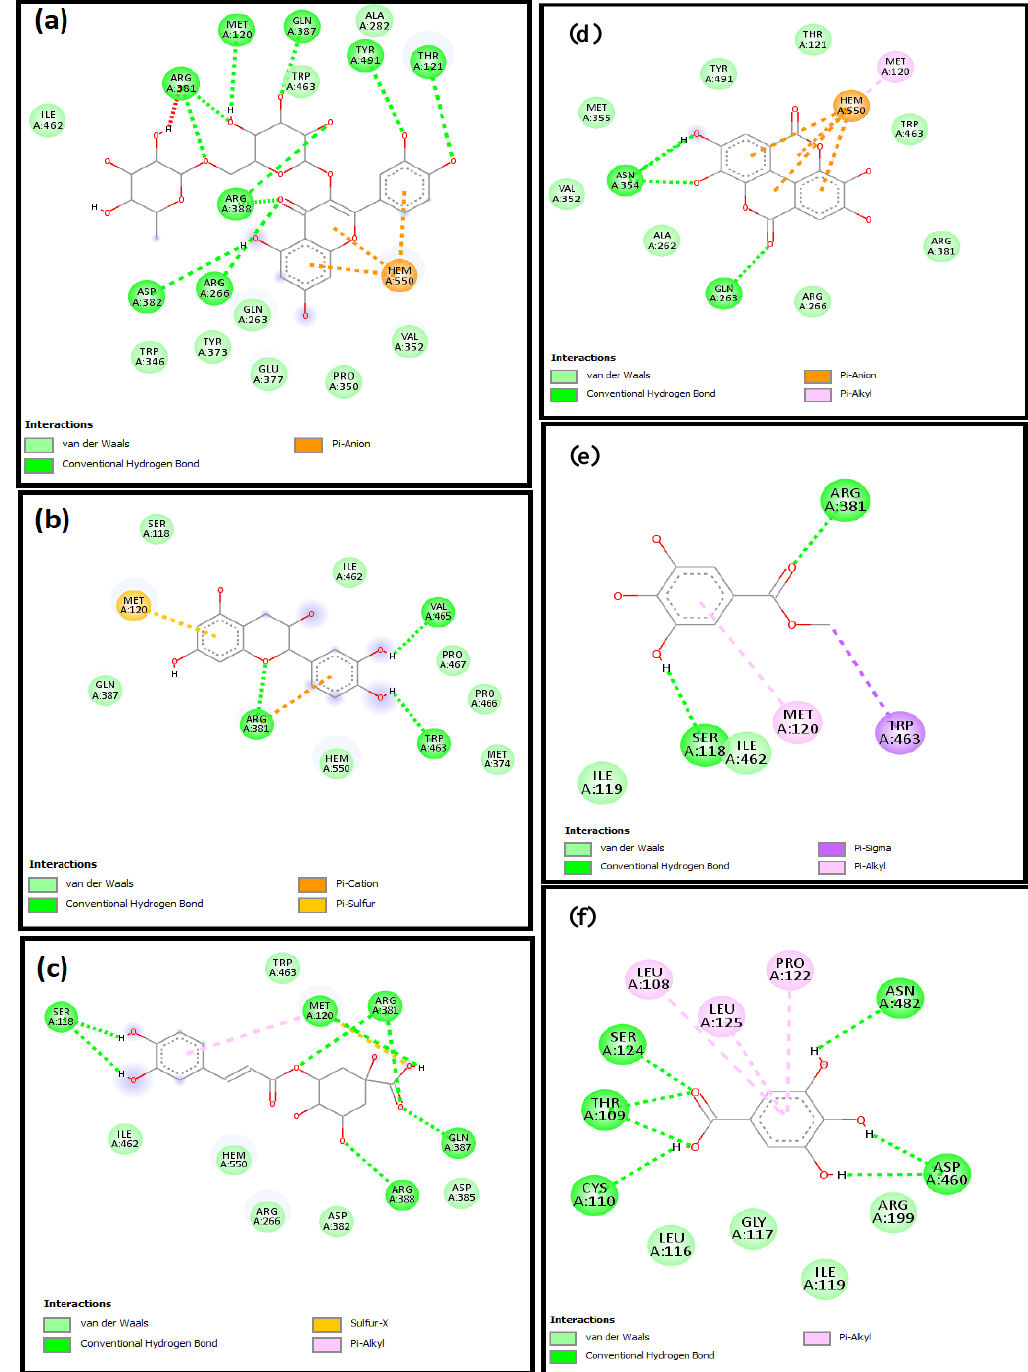
Figure 14. The 2D schematic interactions of docked ( a ) RUT, ( b ) CAT, ( c ) CHL, ( d ) ELL, ( e ) GAT, and ( F ) CAT with human inducible nitric oxide synthase (Code: 1NSI).